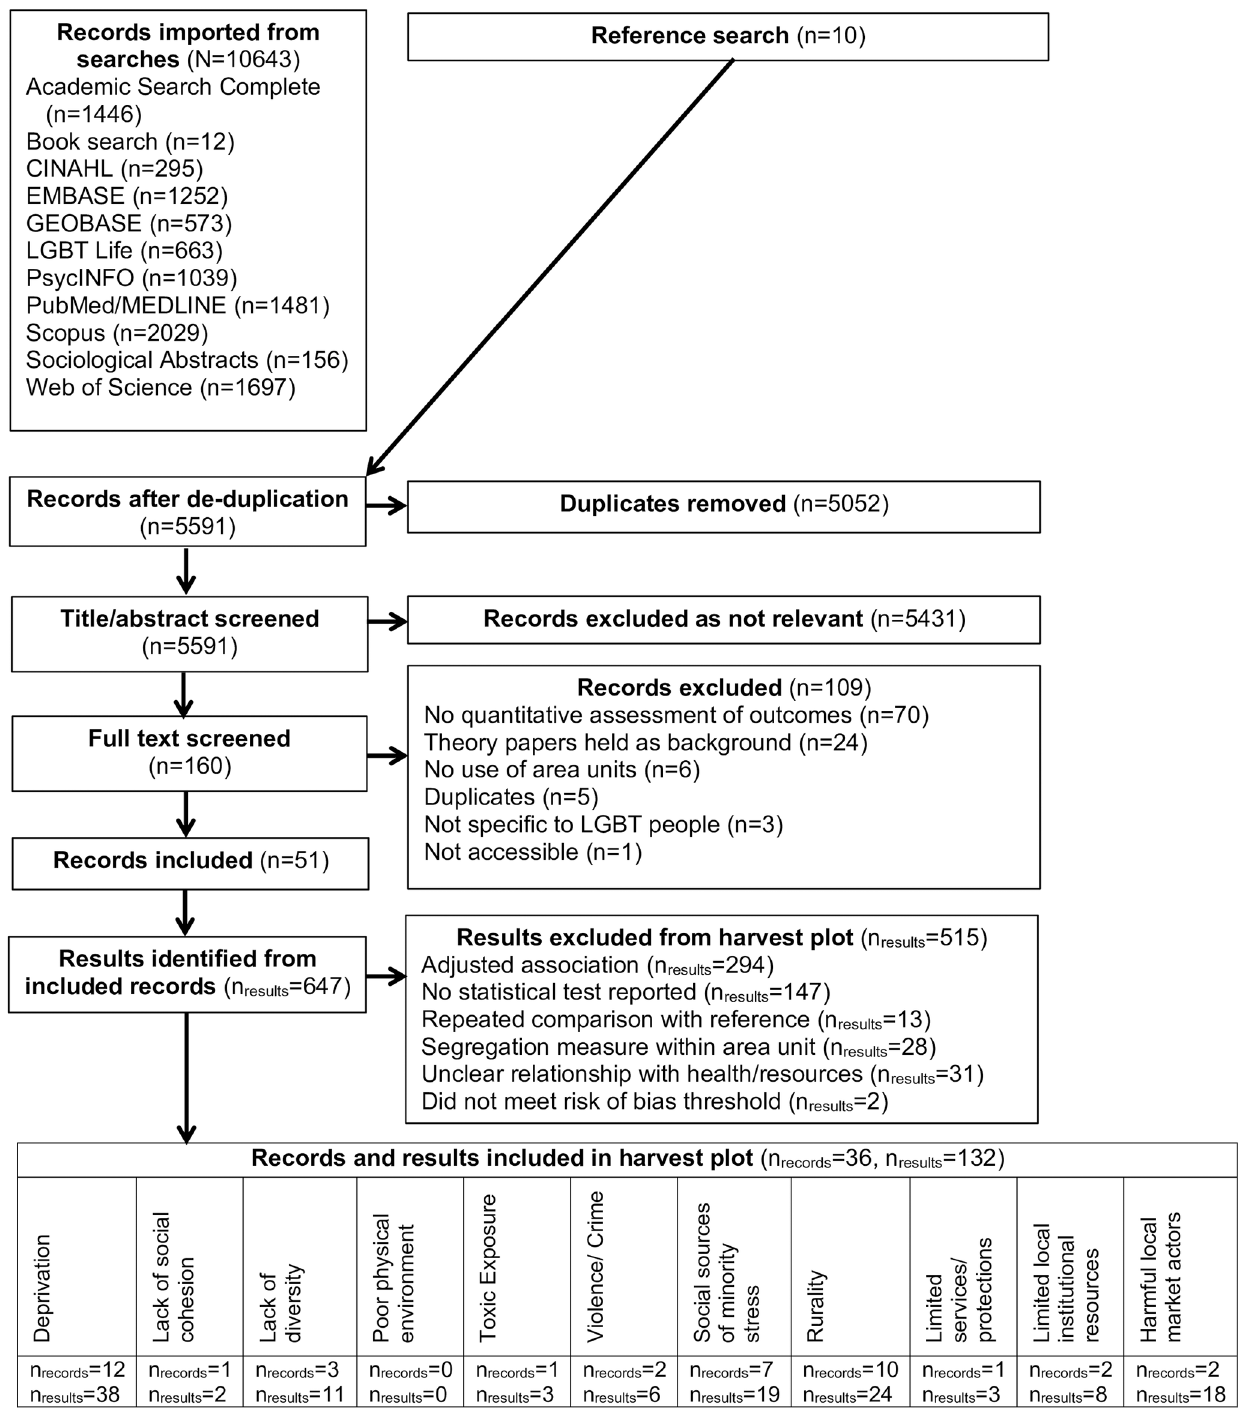
Fig 1. Inclusion flow diagram, Nov. 19–21, 2016.